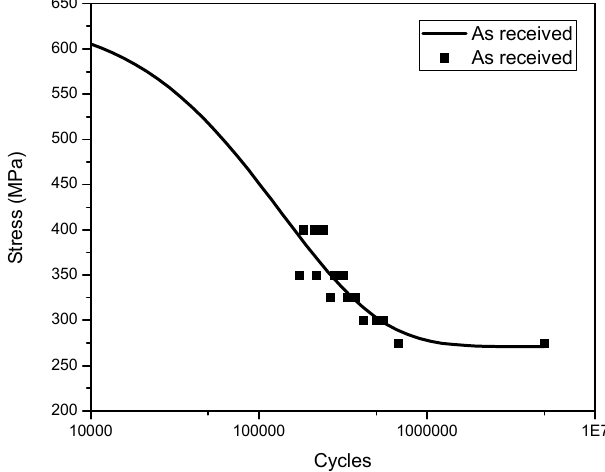
Figure 10: Fatigue results of the as-received